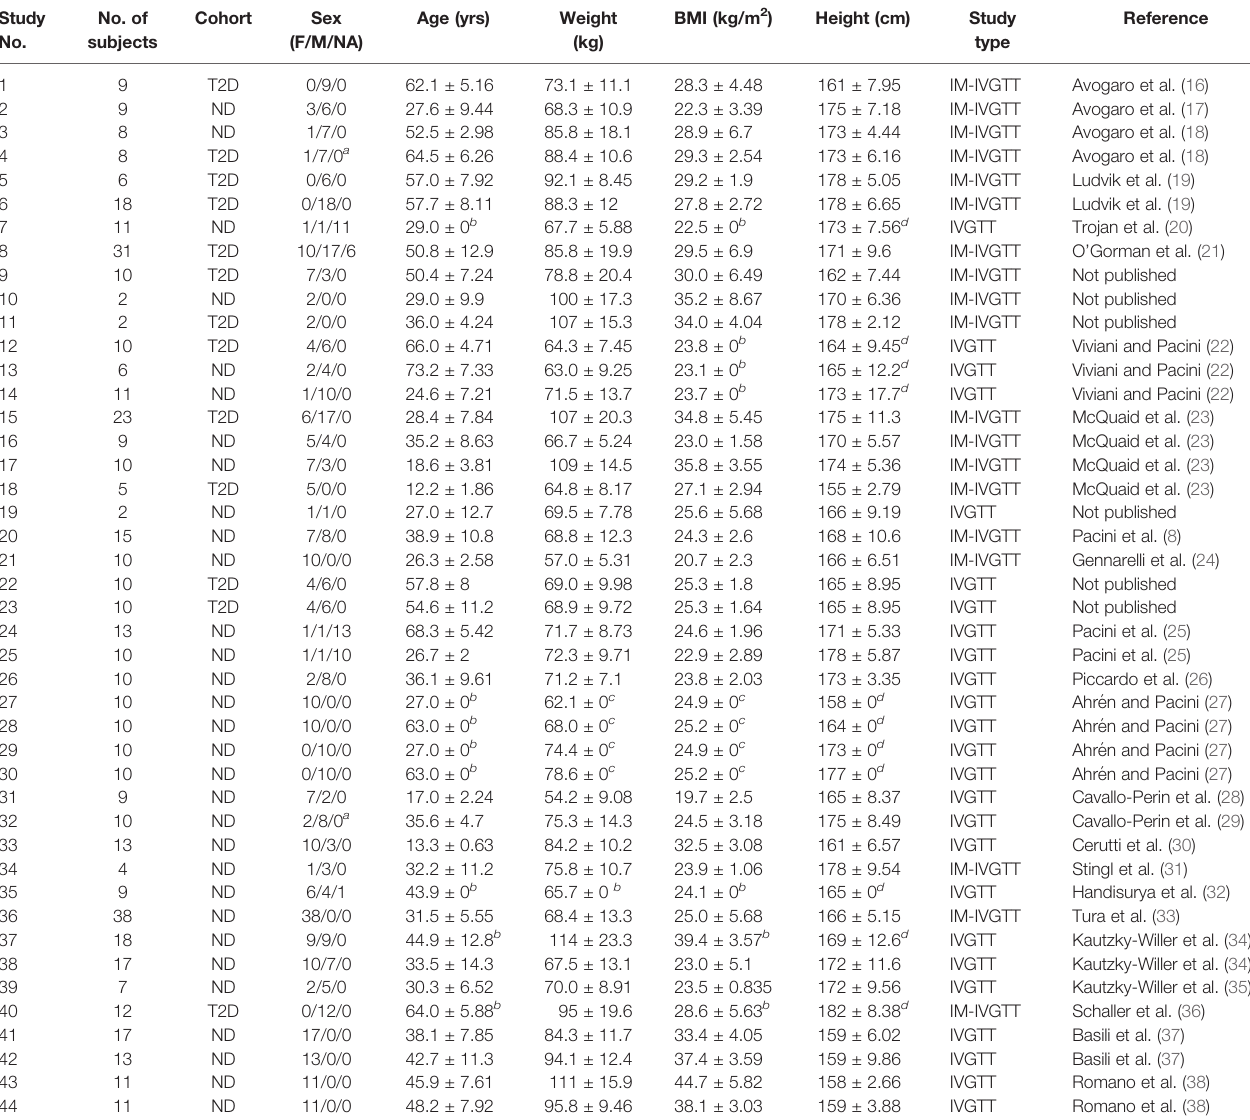
TABLE 1 | Summary of subject characteristics in the studies (mean ± SD). Study